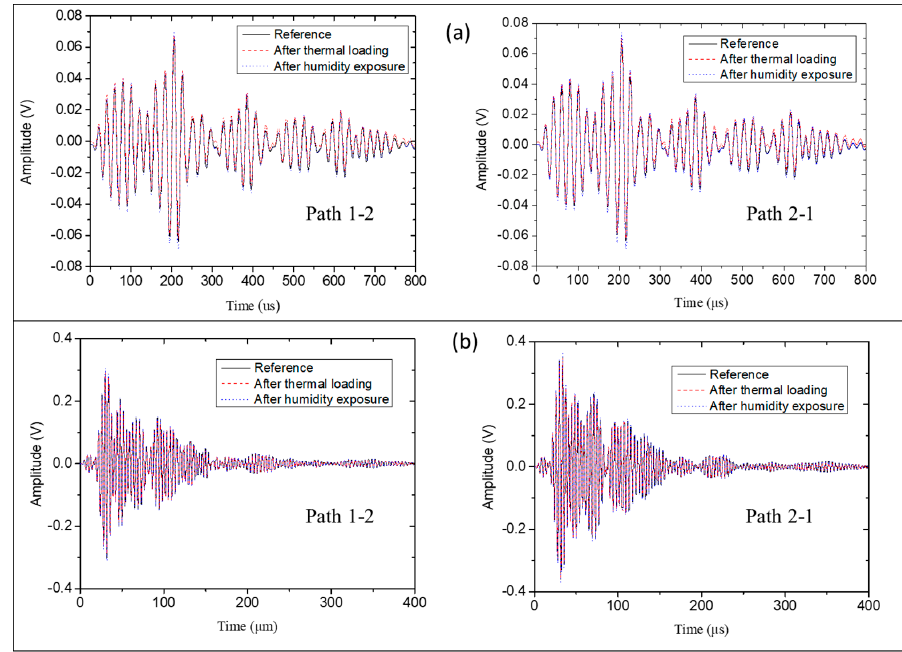
Figure 12. Recorded signals before and after thermal loading tests. Excitation frequencies were ( a ) 50 and ( b ) 250 kHz.